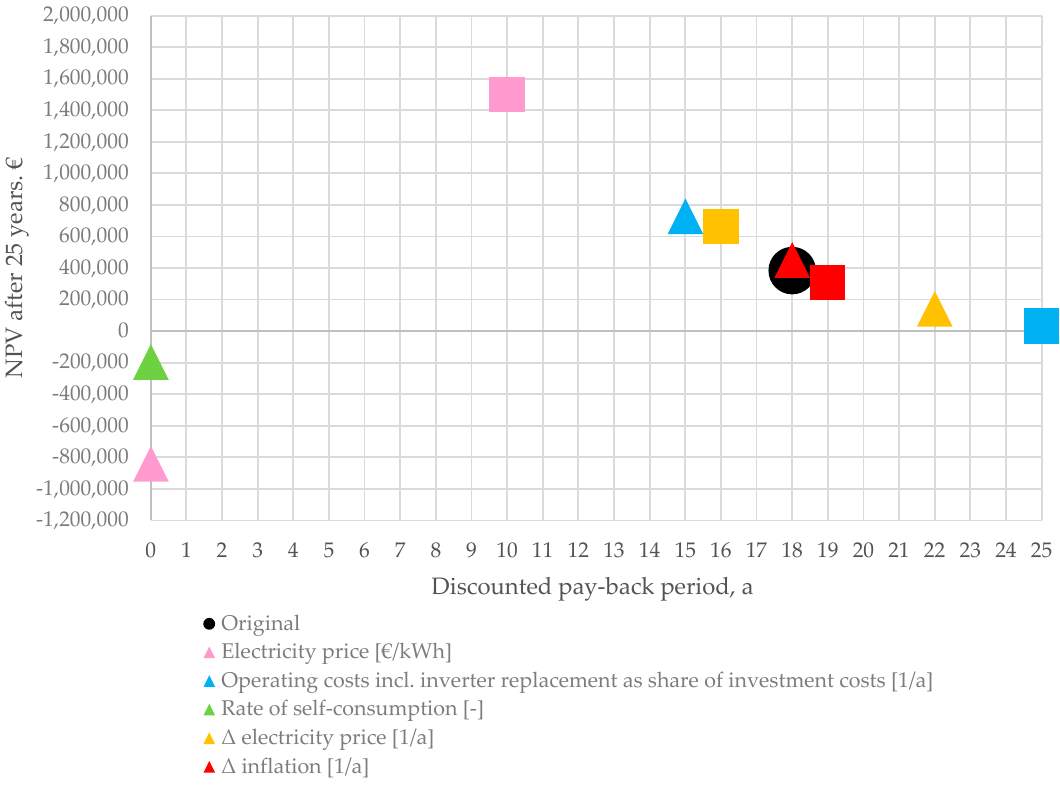
Figure A1. Sensibility analysis of Case 1 debt